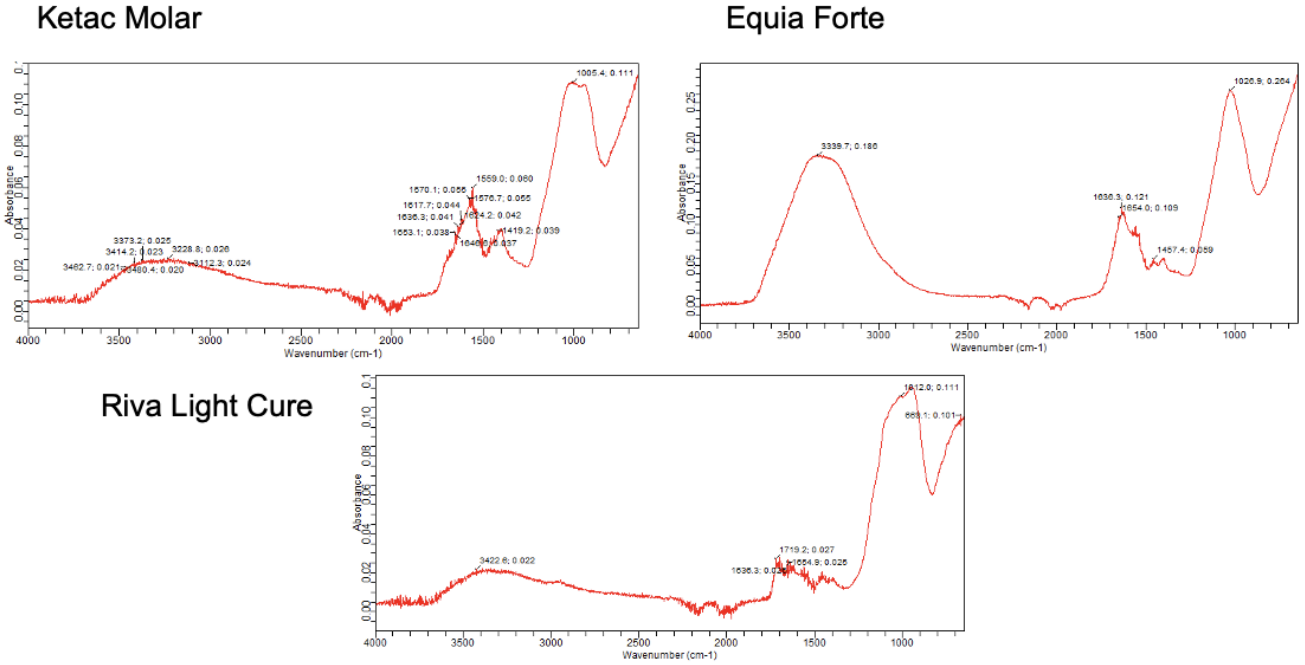
Figure 3. FTIR spectrum of the different pure materials 24 h after setting.